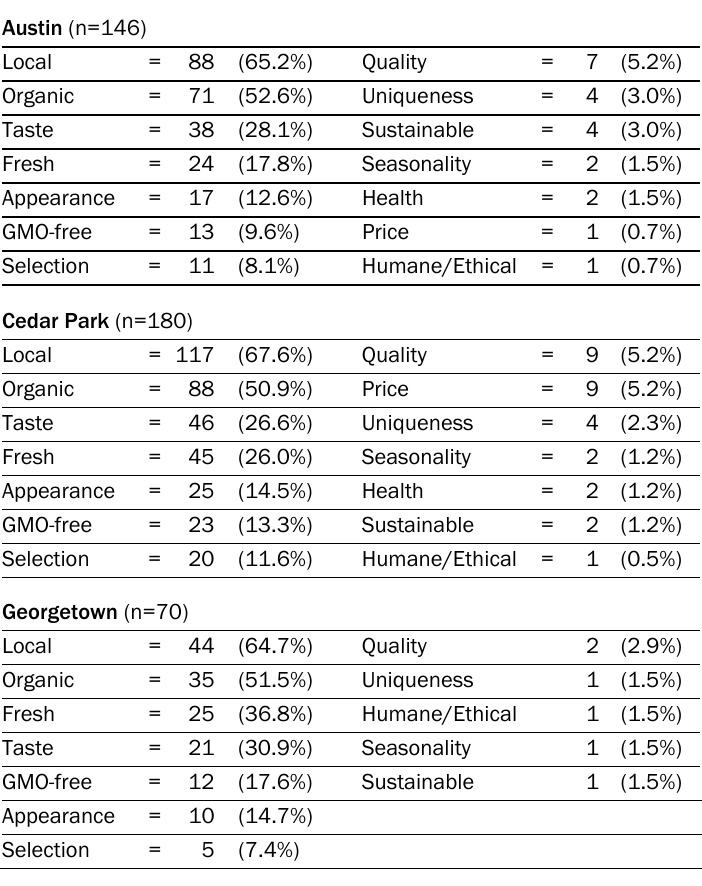
Table 2–B. Responses to the survey question, What is the most important quality or qualities you look for in the items you